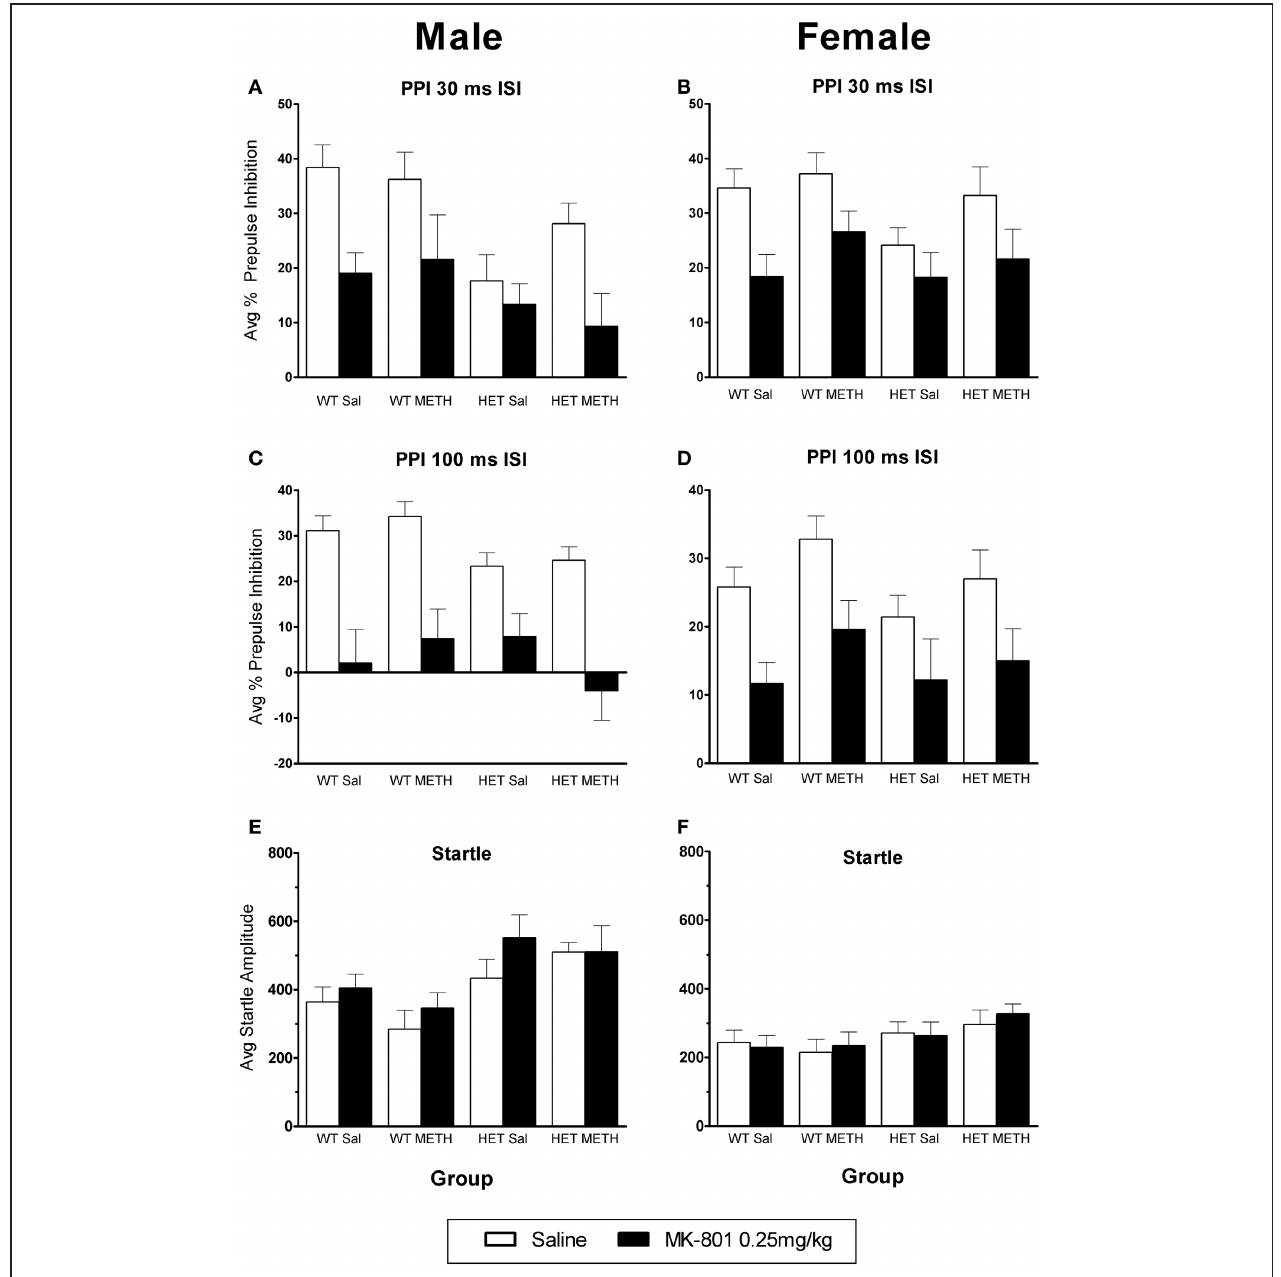
FIGURE 5 | MK-801-induced disruption of PPI. (A–D) PPI following an MK-801 challenge in male (A) and female (B) mice at the 30ms ISI and male (C) and female (D) mice at the 100ms ISI. MK-801 disrupted PPI in all groups,